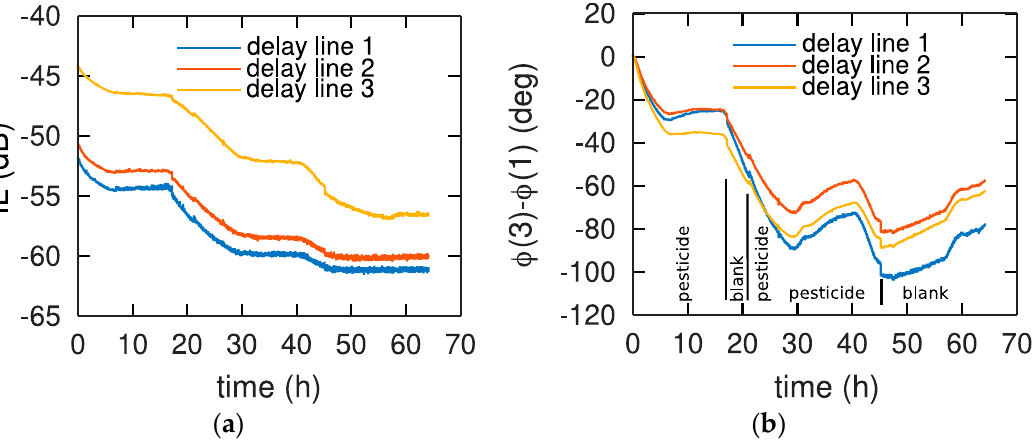
Figure 3. Evolution of ( a ) the insertion loss (IL) of echo 1 and ( b ) the phase difference between echo 1 and echo 2 separated by 800 ns. The measurement steps are indicated on the bottom for each chart since all steps were timestamped, with water-acetonitrile mixture (named blank) or water-acetonitrile containing chlorpyrifos solution (named pesticide) with PBMA as sensing layer.